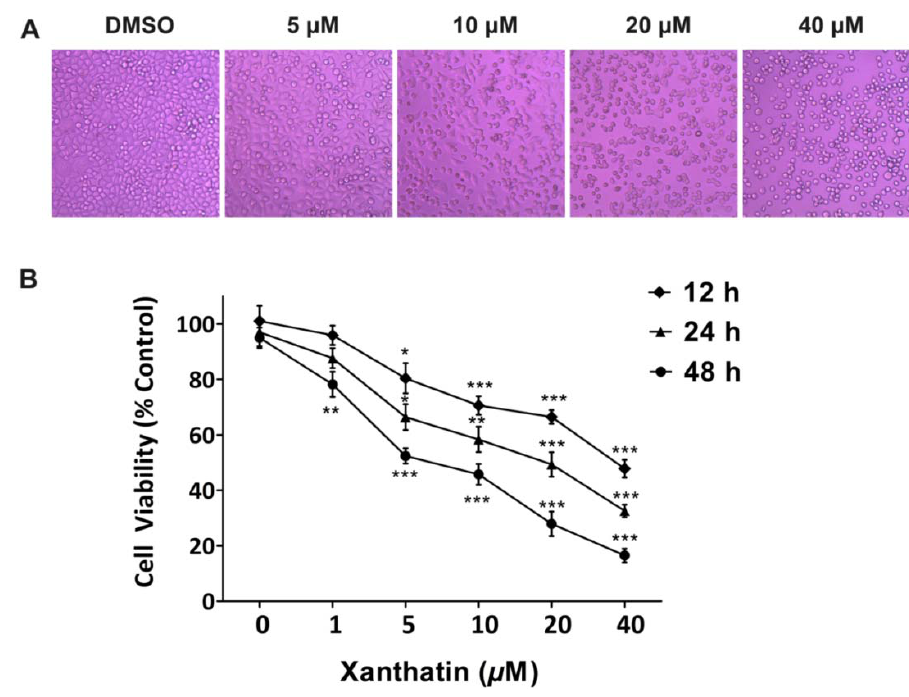
Figure 1. Cytotoxic effects of xanthatin on A549 cells. ( A ) Cell morphology under light microscopy after incubation with xanthatin at indicated concentrations for 24 h (×200); ( B ) Inhibitory effects of xanthatin on the cell viability of A549 cells by MTS assay. Data were presented as means ± SD by three independent experiments. Significance: * p < 0.05 versus the control; ** p < 0.01 versus the control, *** p < 0.001 versus the